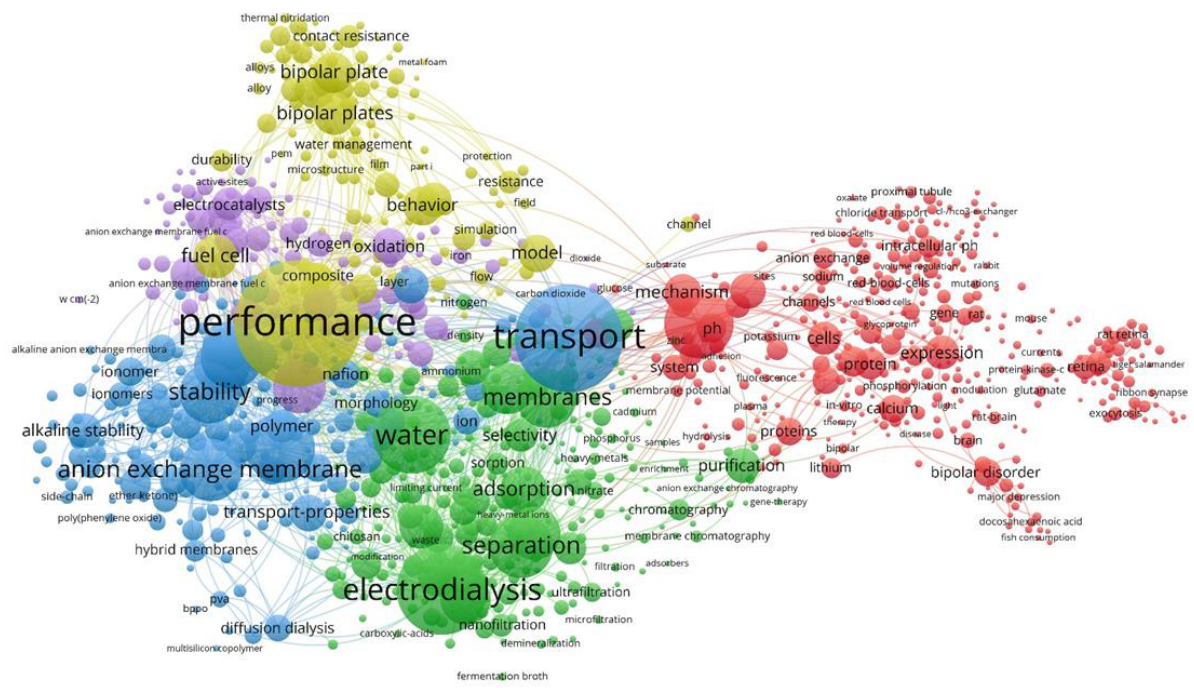
Figure 1. Semantic analysis of the most common key concepts.